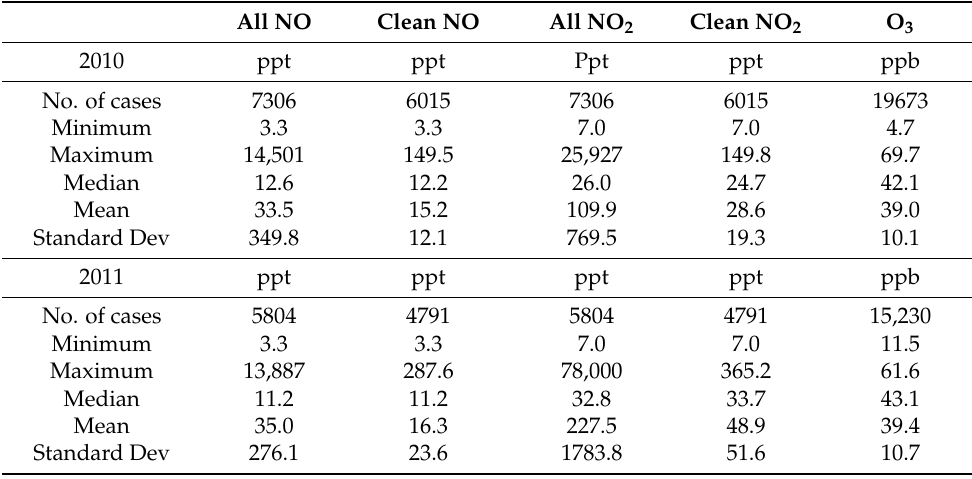
Table 1. Statistics for NO, NO 2 and O 3 concentrations during the Arctic campaigns of 2010, 2011 and 2015. During the 2010 campaign the clean NO and NO 2 data come from